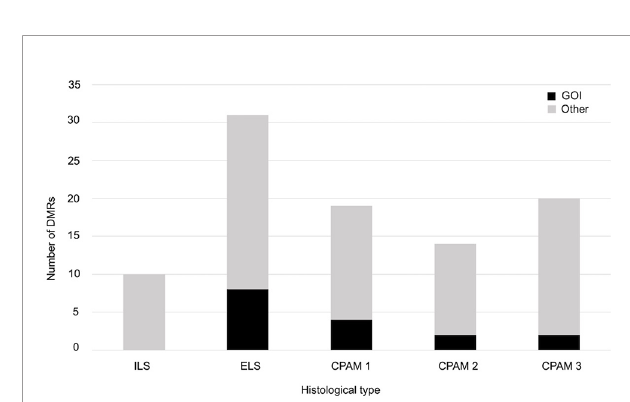
FIGURE 1 | Multidimensional scaling (MDS) plot of (A) malformed and control samples; (B) malformed, control and pleuropulmonary blastoma samples. In each plot, the X axis represents Dimension 1 and the Y axis Dimension 2 of the MDS statistical analysis, which better expresses the mathematical distance between the samples.